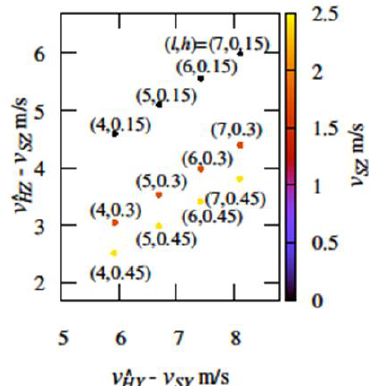
Figure 3. Horizontal and vertical components of the fingertip velocity relative to the shoulder as a function of the vertical fingertip speed relative to the